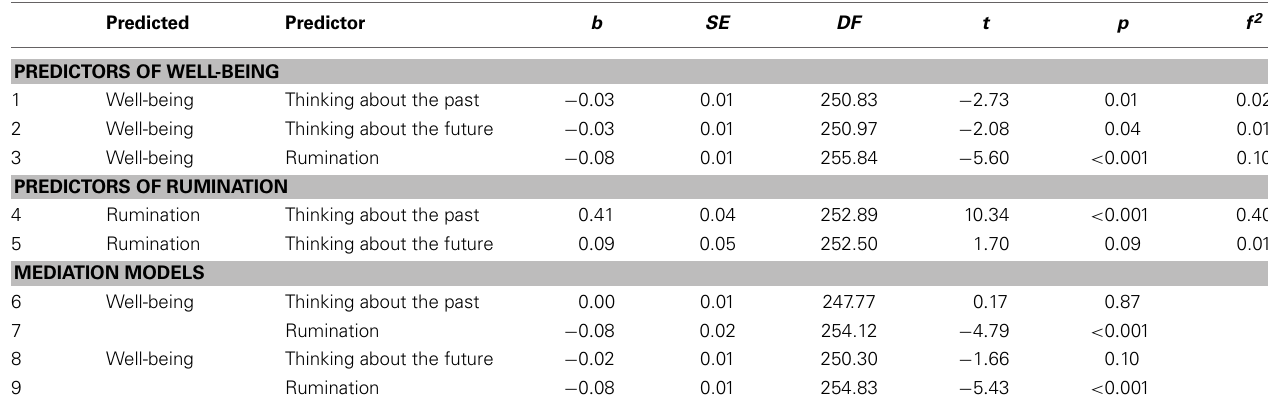
Table 2 | Results of mediation